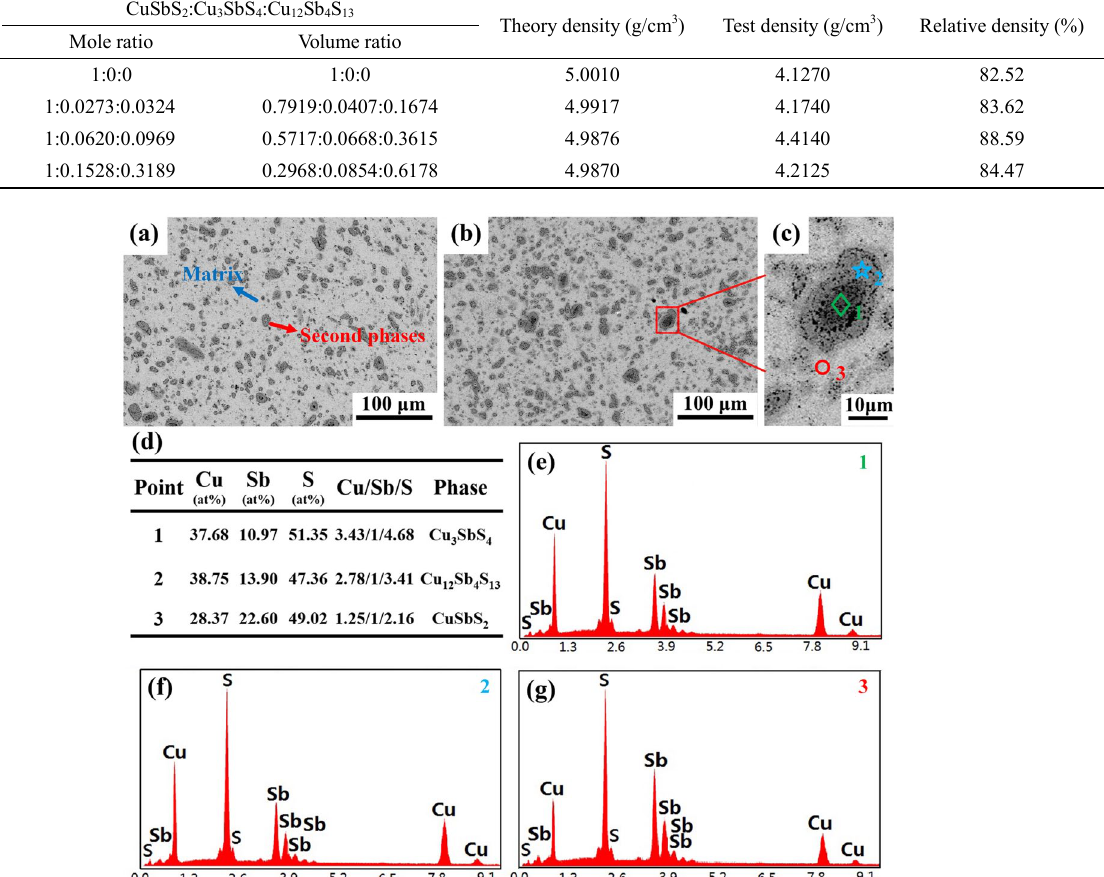
Fig. 4 BSE images and energy dispersive X-ray spectroscopy (EDX) data of the bulk samples with the mole ratio of (1– x )CuSbS 2 – x Cu 1.8 S ( x = 0.2, 0.3). (a) x = 0.2, (b, c) x = 0.3, (d) atomic ratio of Cu/Sb/S, and (e)–(g) EDX